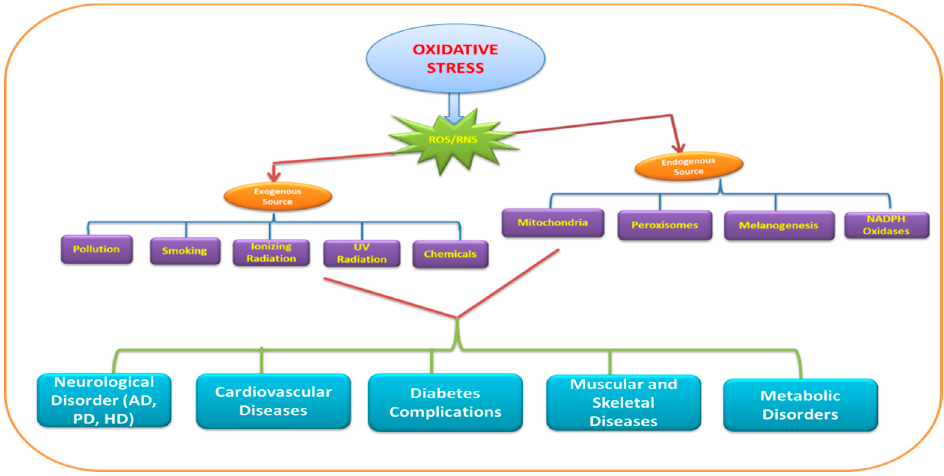
Figure 1. representation of exogenous and endogenous sources of reactive oxygen species (ROS)/reactive nitrogen species (RNS) anddiseases.PD—Parkinson’s disease; AD—Alzheimer’s disease; HD—Huntington’s